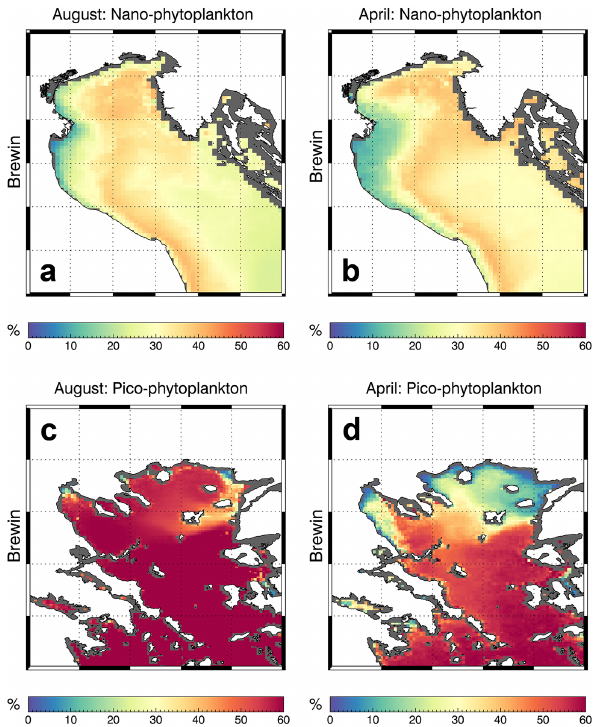
Figure 5. Seasonal spring to summer excursion of nano- and pico-phytoplankton fractions (%) of TChl a in two sectors. Nano- phytoplankton percentages in the North Adriatic Sea for August (a) and April (b) climatology (1998–2010). Pico-phytoplankton percentages in the Aegean Sea for August (c) and April (d) clima- tology